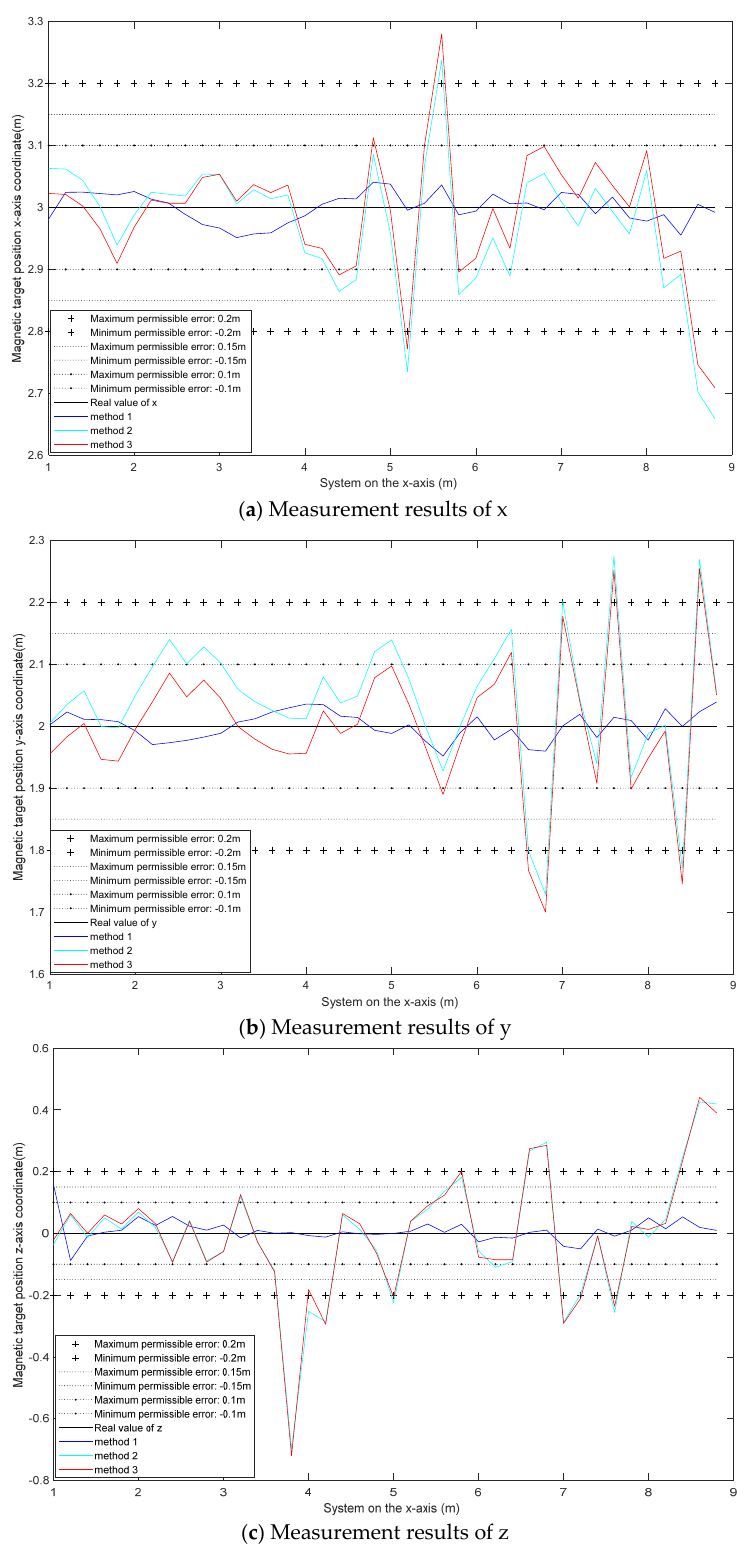
magnetic field. The localization results are shown in Figure 5.